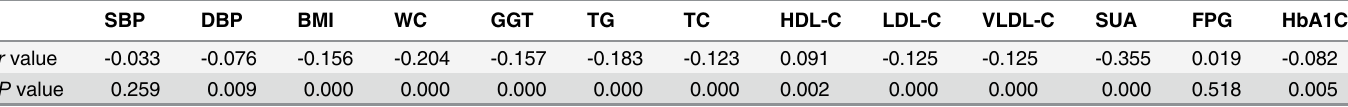
Table 2. Correlations between eGFR and NAFLD related risk factors.